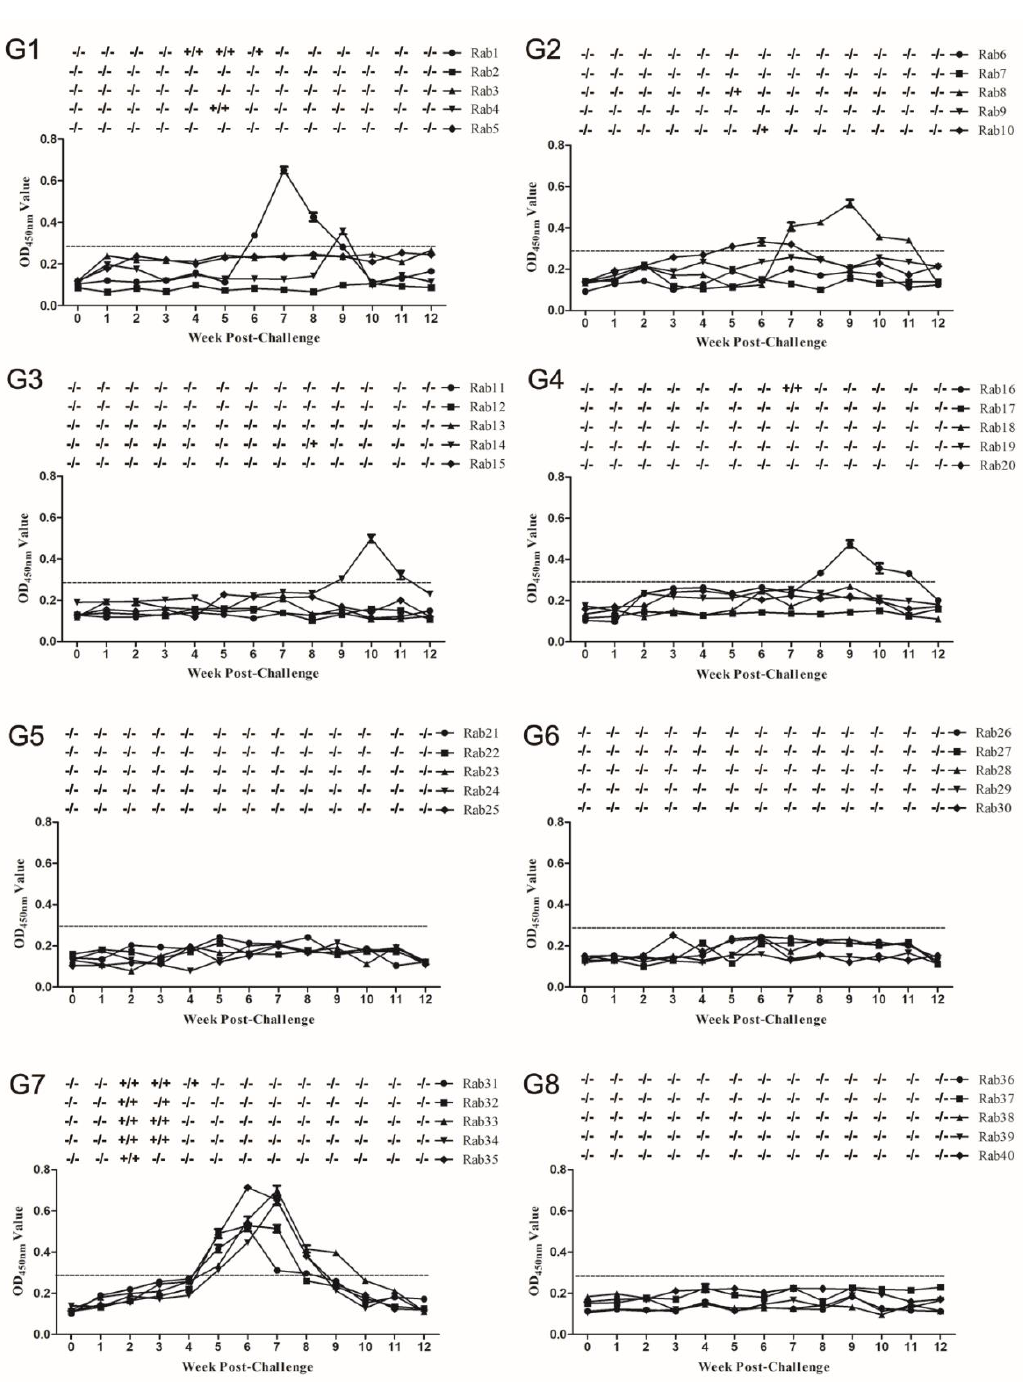
Figure 3. Time course of seroconversion, viremia, and fecal virus shedding in specific-pathogen-free (SPF) rabbits after challenge with CHN-SD-sHEV. SPF rabbits immunized with Pep VKLYTS ( G1 ), Pep PSRPF ( G2 ), Pep EPTV ( G3 ), Pep EPTVKLYTS ( G4 ), Pep EPTVKLYTSPSRPF ( G5 ), sp239 protein ( G6 ), or PBS (( G7 ), negative control); Rabbits challenged with PBS ( G8 ) as normal control. HEV RNA was detected by RT-nPCR. Fecal or serum HEV RNA presence or absence are indicated by “ + ” and “ − ”, respectively. Serum and fecal samples were collected before virus inoculation and various weeks post challenge (wpc). The error bar indicates confidence interval of reduplicates of three test wells.